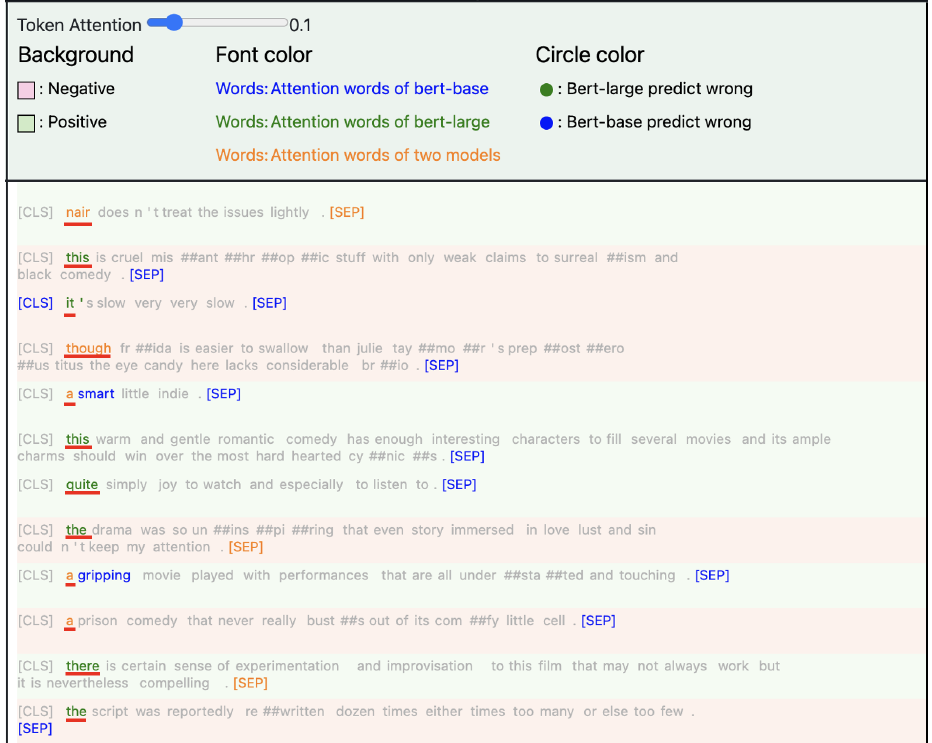
Figure 25. Almost all attention words of the bert-large model are the first word of